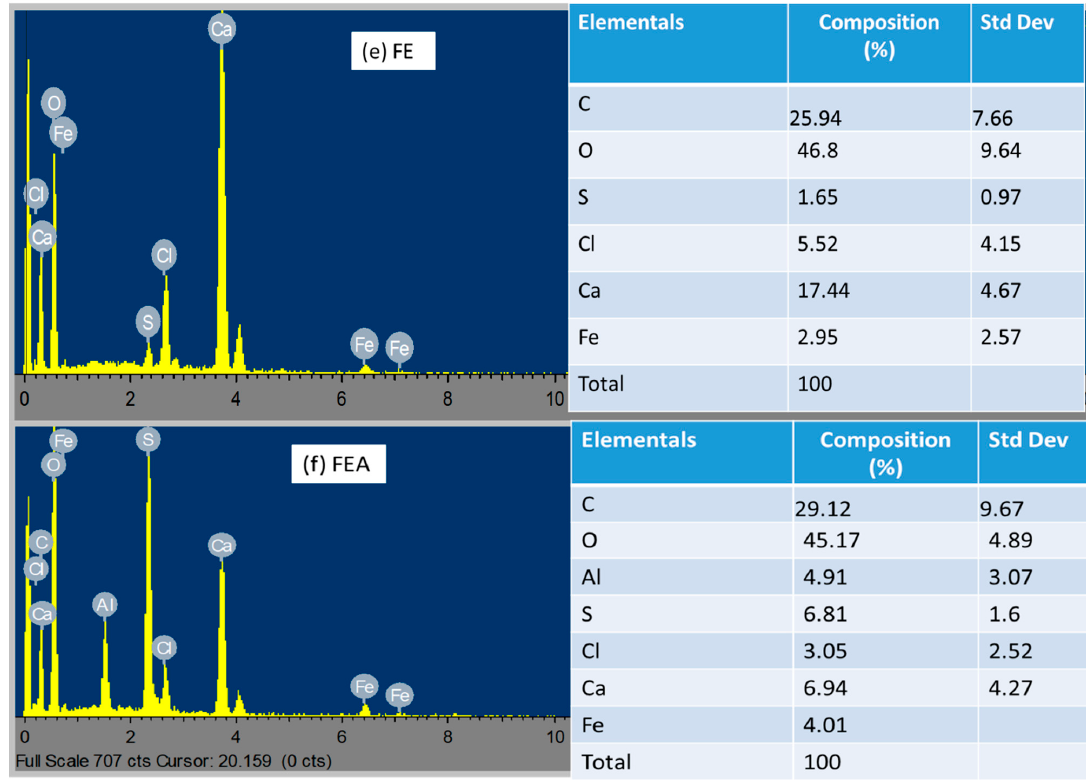
Figure 2. EDX image spectra of ( a ) ferromagnetite (F), ( b ) alum (A), ( c ) eggshells (E), ( d ) FA, ( e ) FE, and ( f ) FEA.